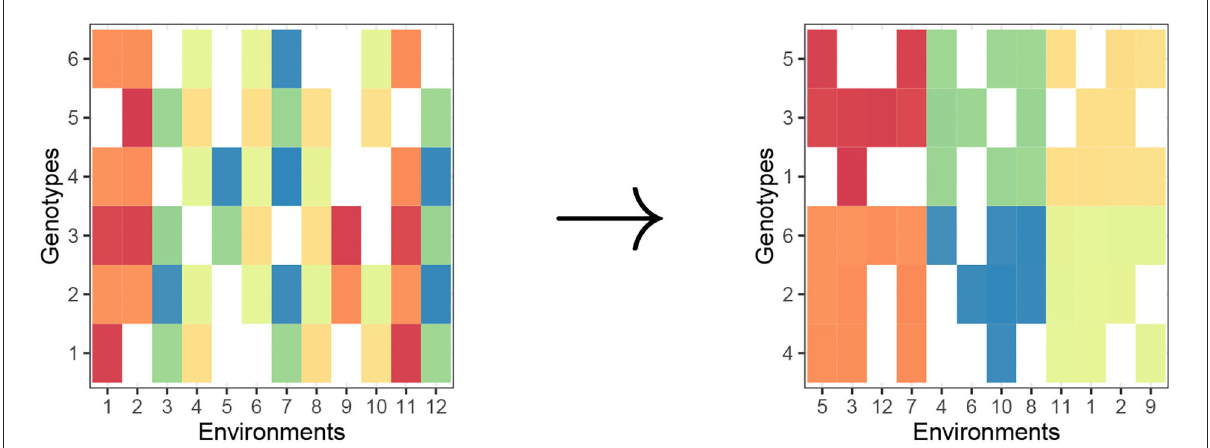
FIGURE1 Biclustering creates row clusters (genotypes) and column clusters (environments) with homogeneous phenotype in a checkerboard pattern. Raw matrix (left) and “checkerboard-like” biclustering (right)